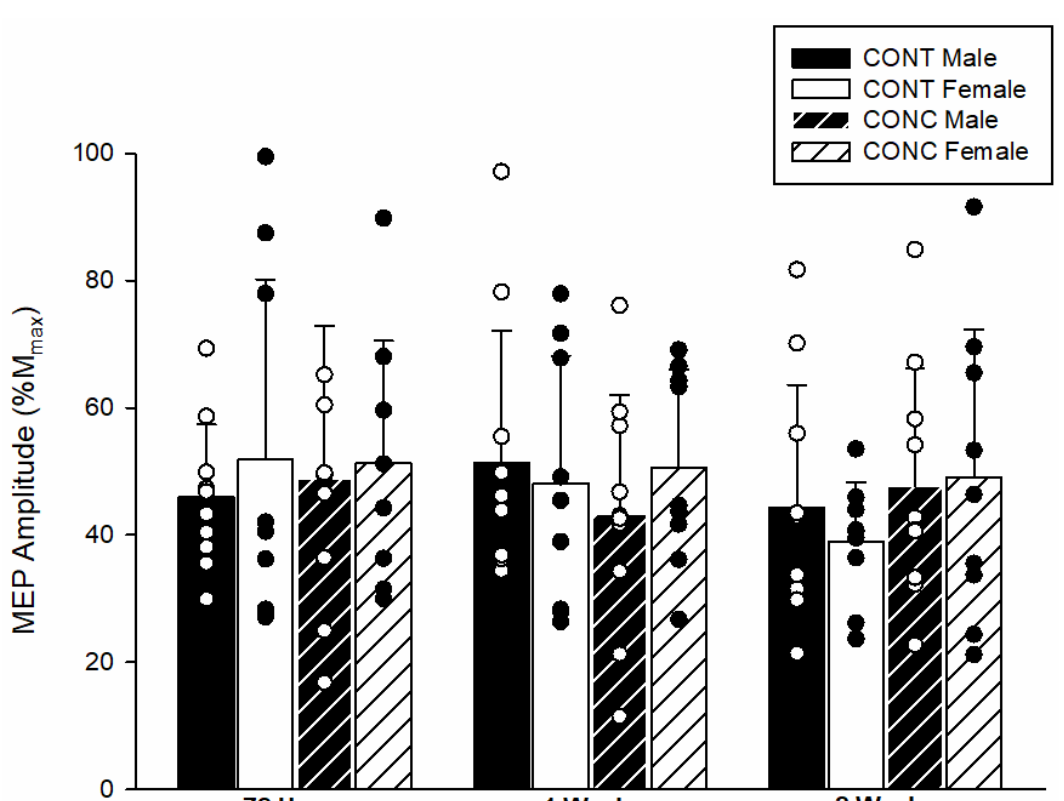
Figure 2. MEP amplitude across the two-week testing period. The MEP amplitude was similar between groups ( p = 0.72) and sexes ( p = 0.77) across all time points. Circles represent individual data points.